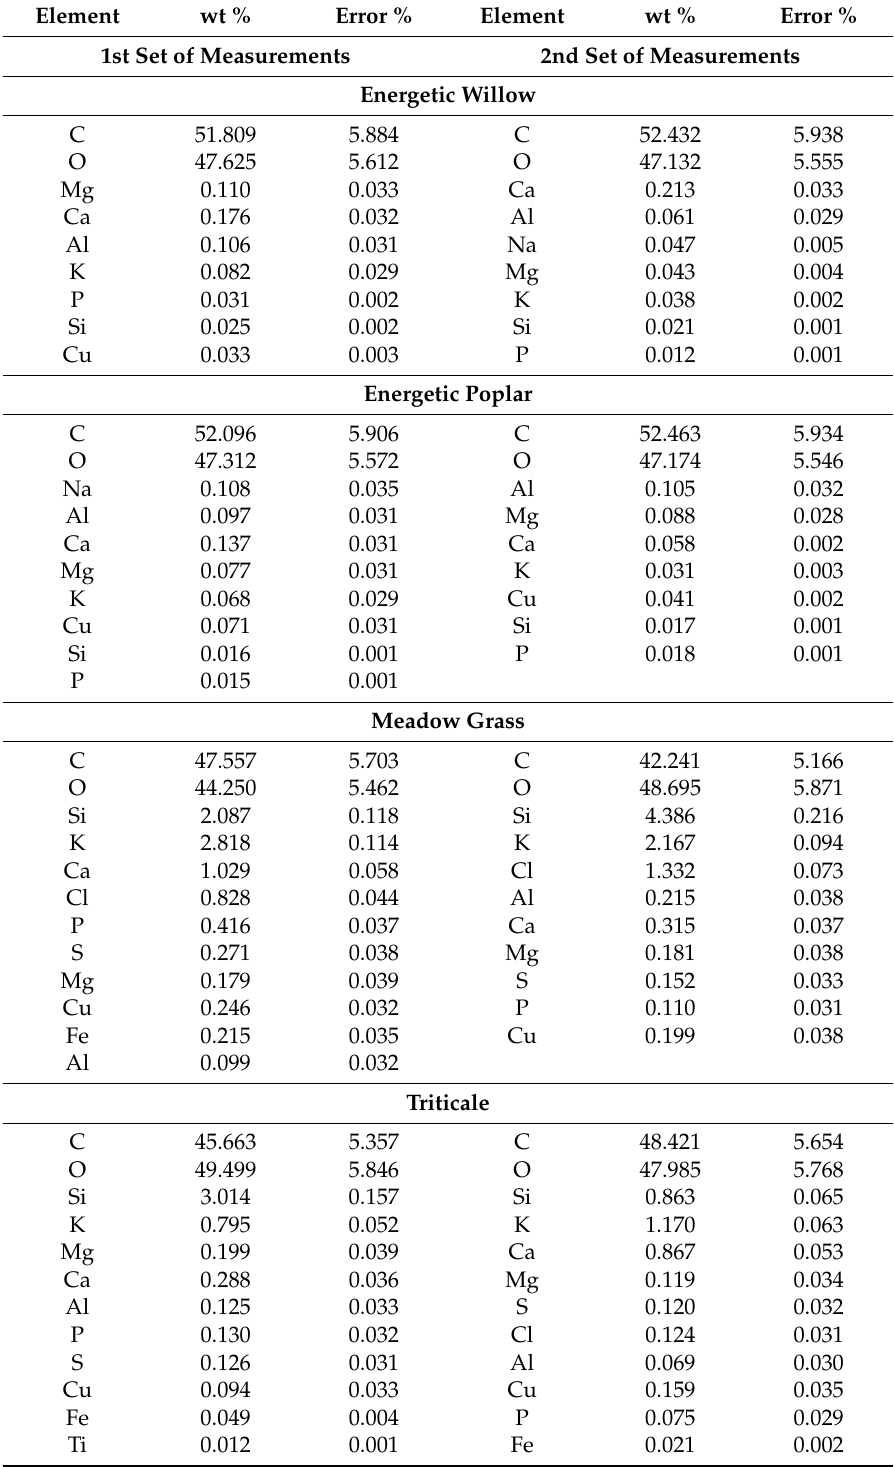
Table A1. Results of EDX measurements for elemental composition of investigated